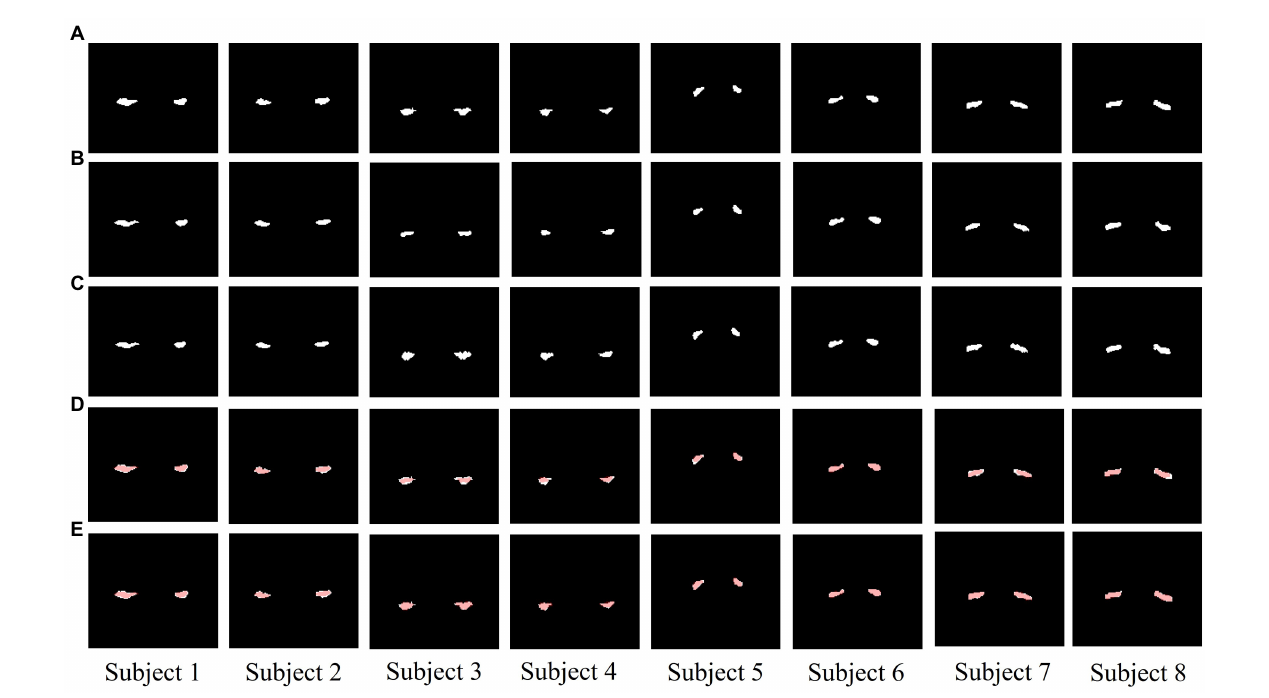
FIGURE 2 The segmentation results of U 2 -net (A–E) . (A) ground truth (GT). (B) Segmentation results before data augmentation. (C) Segmentation results after data augmentation. (D) The difference between GT and segmentation results before data augmentation (red areas are the segmentation results). (E) The difference between GT and segmentation results after data augmentation (red areas are the segmentation results). Columns from left to right are the samples (Subject 1–8).